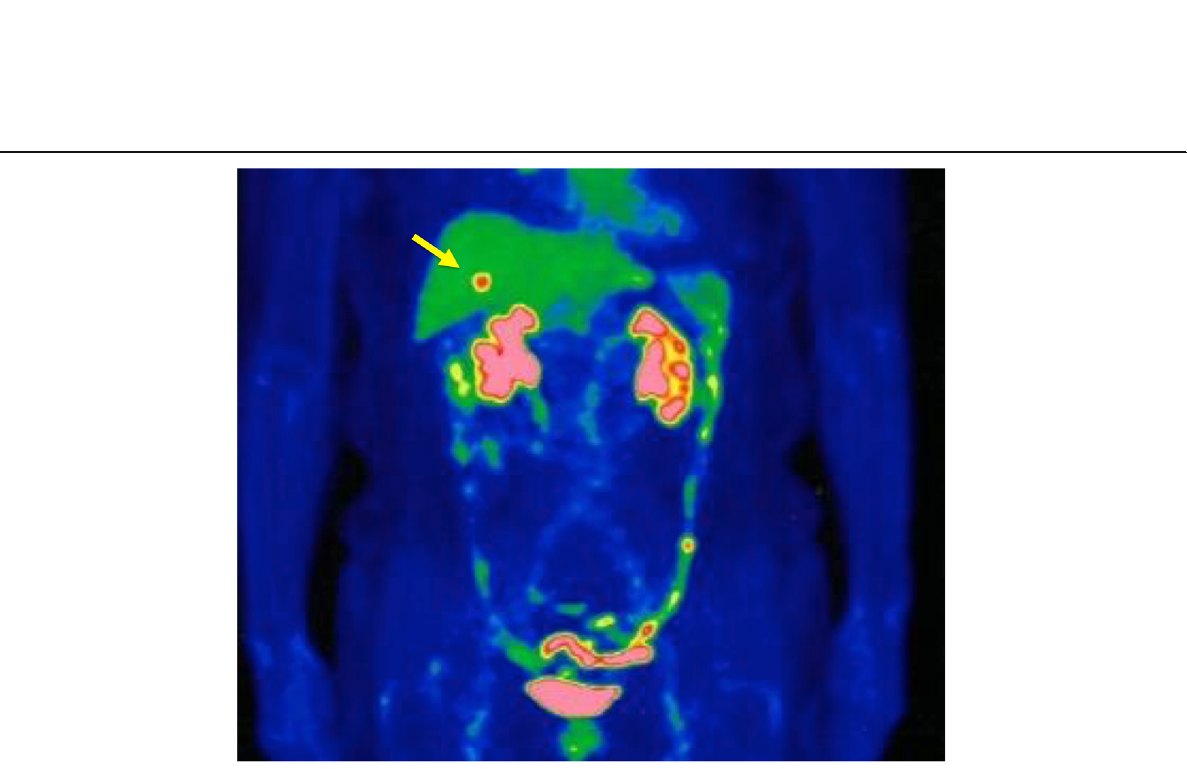
Fig. 5 PET imaging. PET showed an abnormal FDG uptake (SUVmax 5.97) in the gallbladder (see the arrow). No other metastases were